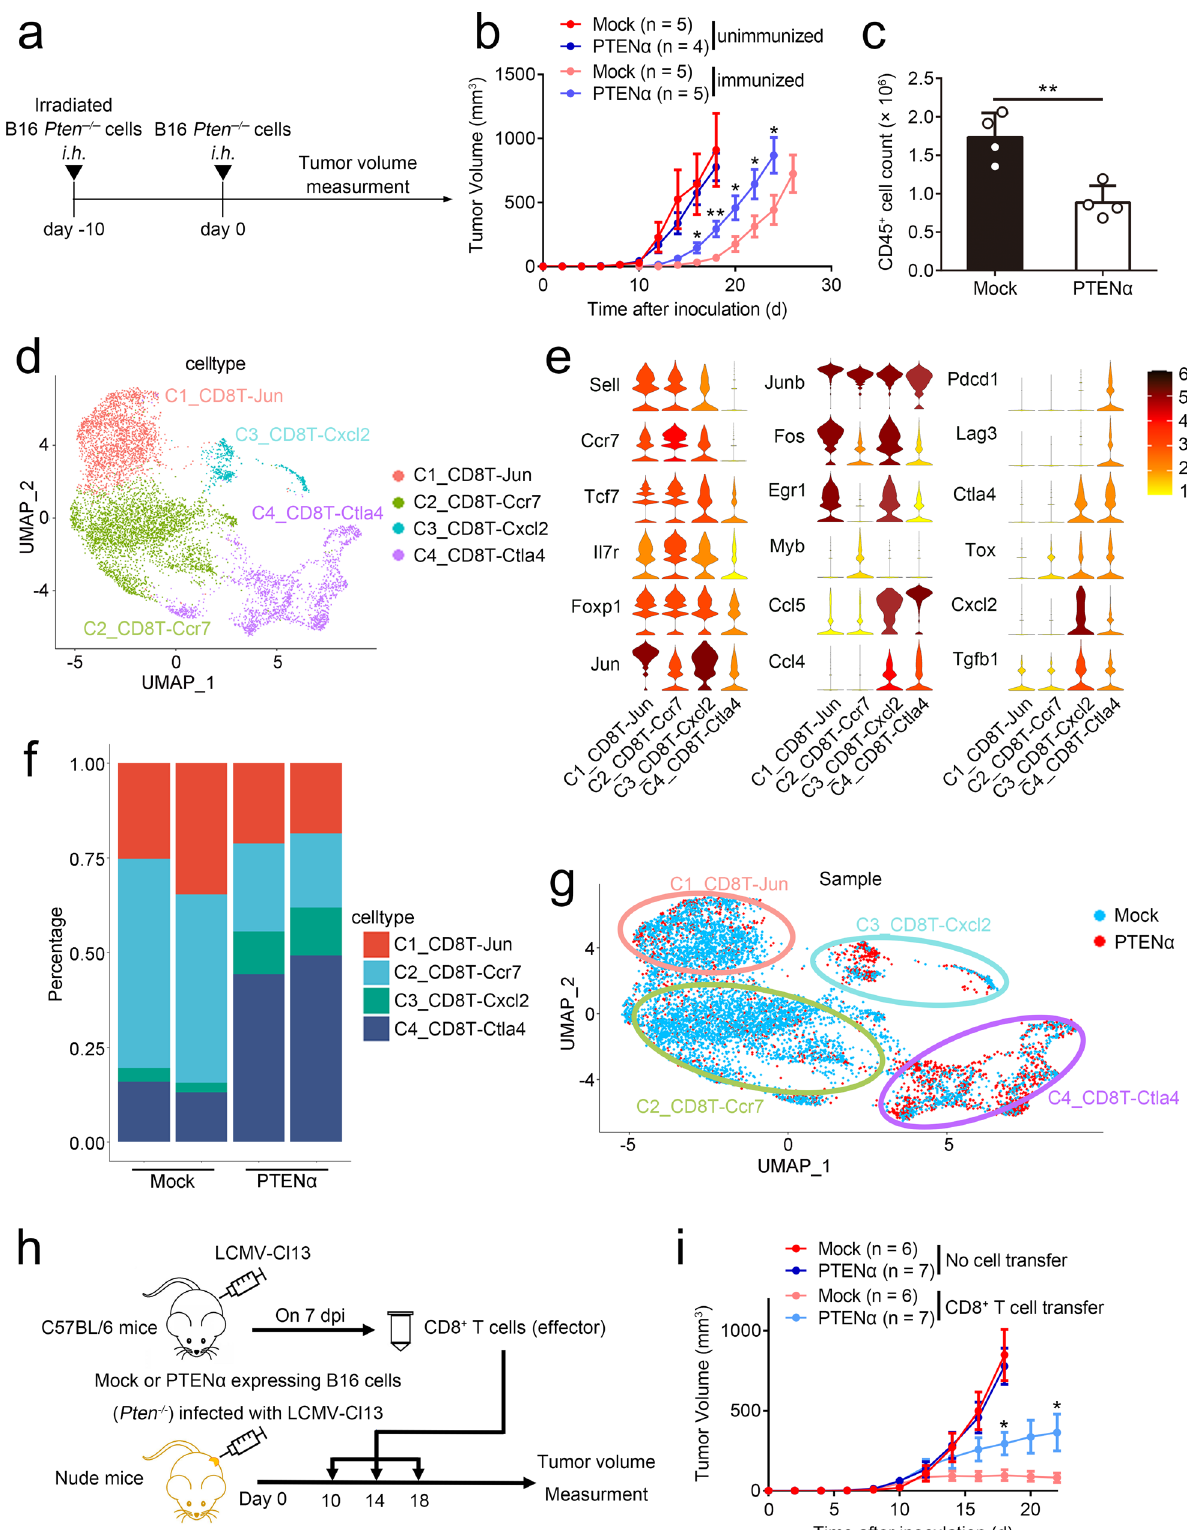
Supplementary Fig. 5b, Pten α − / − T cells produced greater amounts of effector cytokines than wild-type T cells upon exposure to viral peptide. Similar results were also observed in virus-speci fi c T cells from spleens (Supplementary Fig. 5c – e). These data thus indicate that deletion of PTEN α blocks T cell